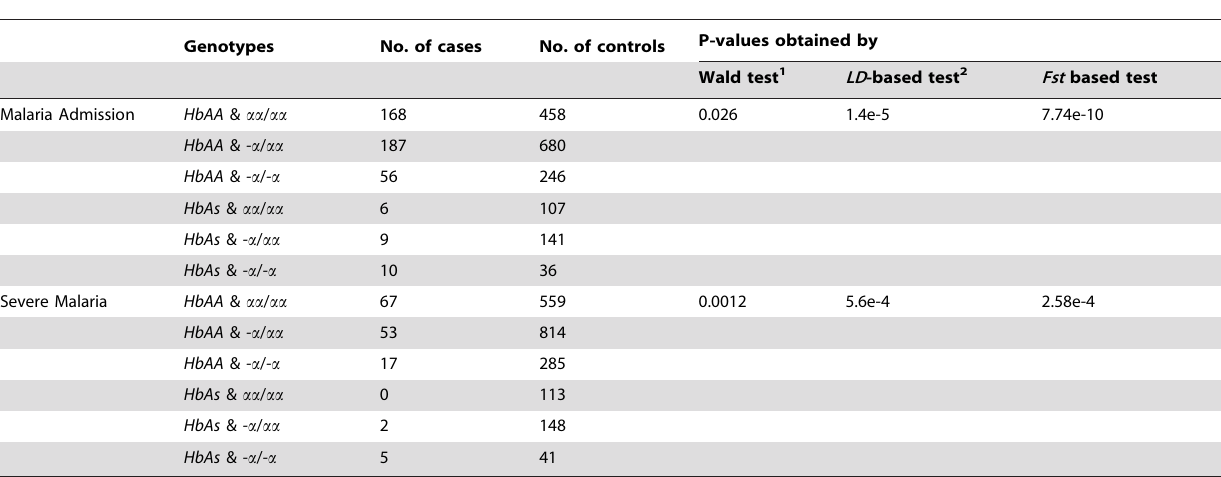
Table 1. Comparison of P-Values for detecting gene-gene